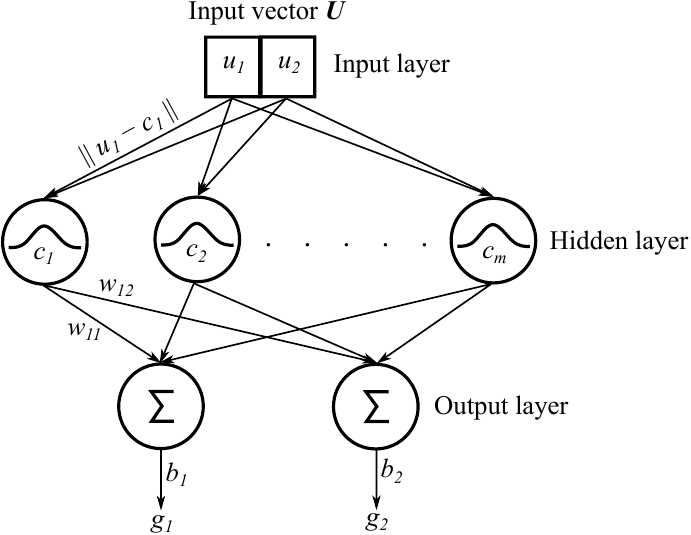
Figure 5. Structure of the applied RBF